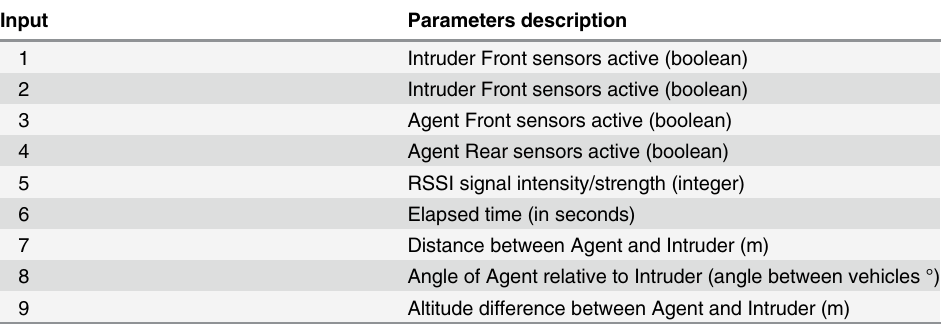
Table 2. Input parameters.